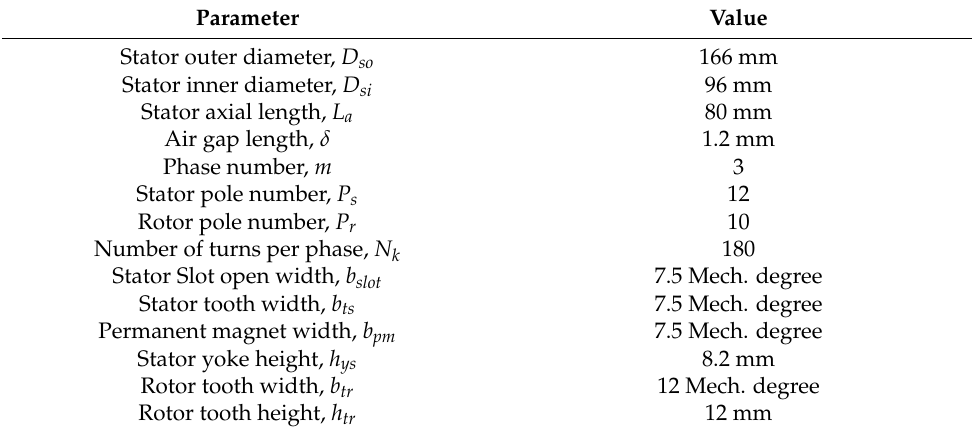
Table 2. Designed specifications of the FSPM motor.